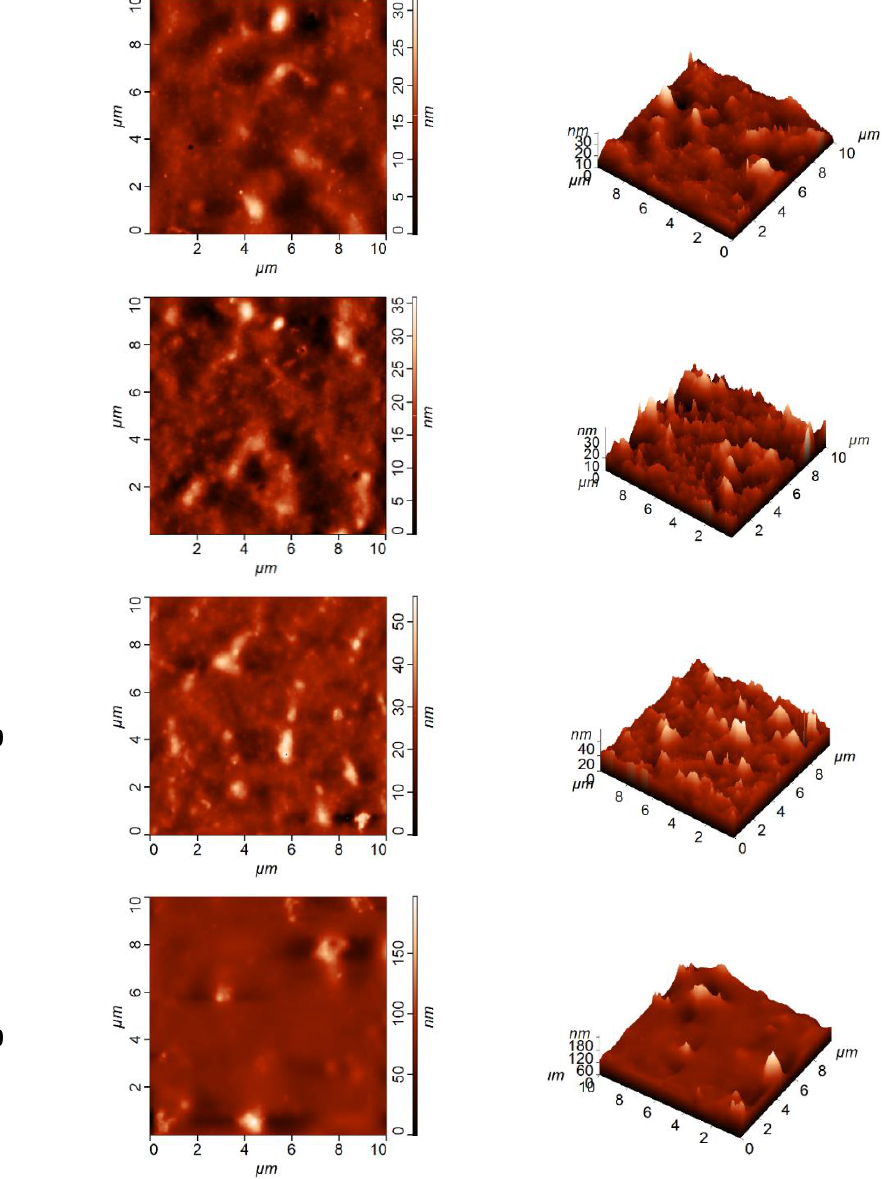
Figure 8. AFM images of the surface of the selective layer of TFC and TFN membranes prepared by physical adsorption.